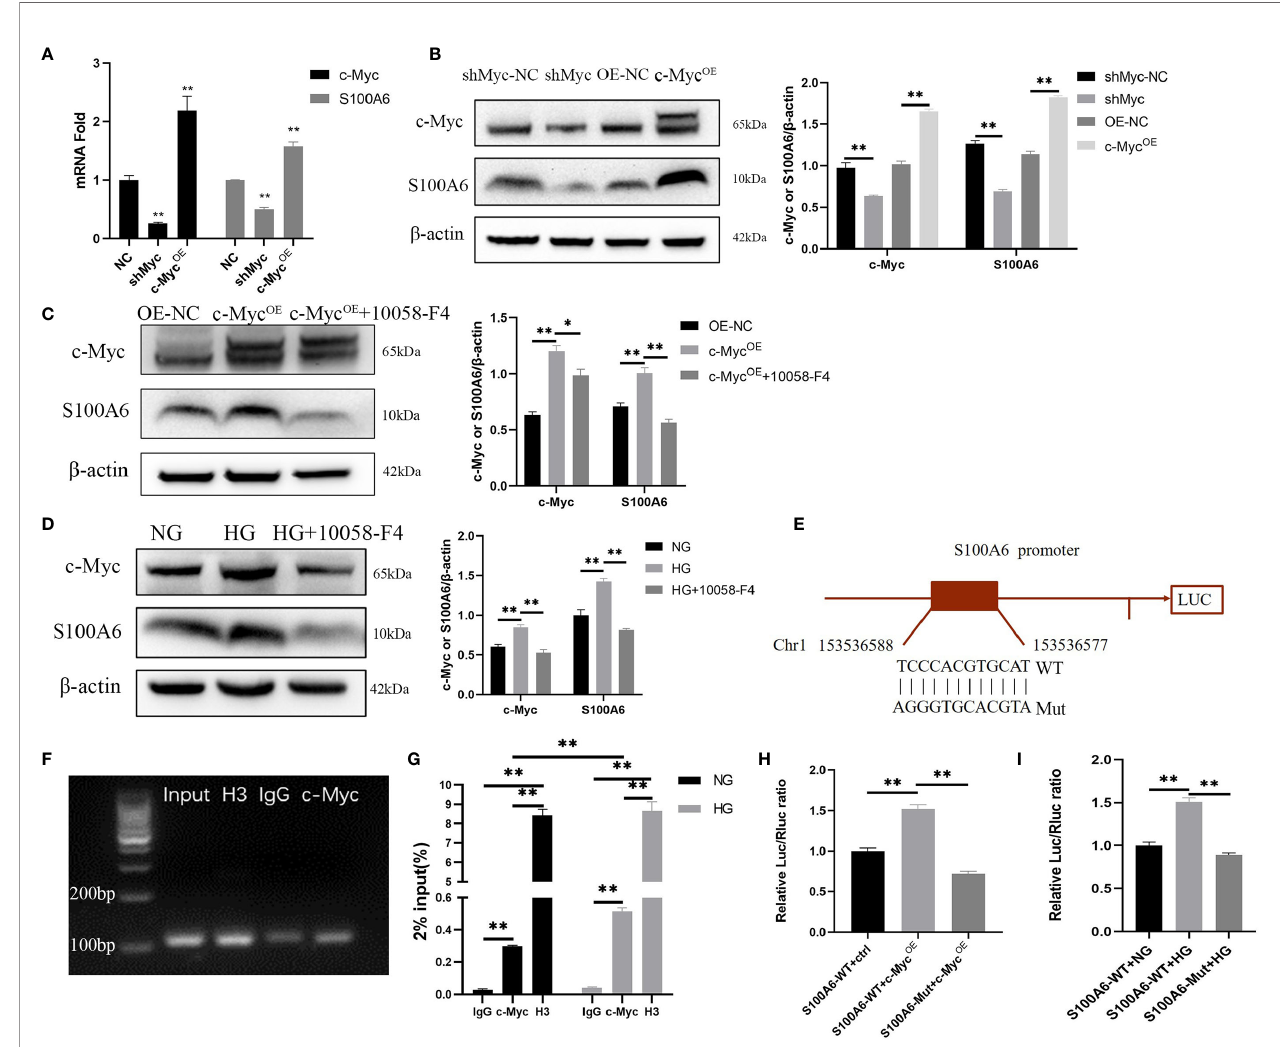
FIGURE 5 | S100A6 is directly transcriptionally regulated by c-Myc (A, B) The mRNA (A) and protein (B) expressions of c-Myc and S100A6 were determined in HaCaT cells with c-Myc overexpression or knockdown. (C, D) The protein expression levels of c-Myc and S100A6 were determined in HaCaT cells pre-treated with 10058-F4 (20 m M). (E) The predicted binding site of c-Myc in the S100A6 promoter region on the Jaspar database (http://jaspar.genereg.net/)(relative pro fi le score threshold 90%) and scheme of mutation strategies in the S100A6 promoter. WT, wild-type; Mut, mutant. (F) ChIP-qPCR products were visualized by agarose gel electrophoresis. (G) The ef fi ciency of ChIP was calculated as percent input = 2% × 2 (CT 2%Input Sample – CT IP Sample) . (H) 500ng c-Myc overexpression plasmid or control plasmid was co-transfected with 500 ng plasmids containing S100A6 gene promoter/Fire fl y luciferase construct and 50 ng Renilla into 293T cells in the NG condition. Fire fl y and Renilla luciferase activities were measured 36 h after transfection. (I) 293T cells were cultured in the NG or HG condition for 5d and then co- transfected with plasmids containing S100A6 gene promoter/Fire fl y luciferase construct and 50 ng Renilla. Fire fl y and Renilla luciferase activities were measured 36 h after transfection. OE-NC, the negative control of c-Myc overexpression. shMyc-NC, the negative control of c-Myc knockdown. Data were shown as the mean ± SEM measured in triplicate from three independent experiments. ANOVA followed by Tukey ’ s multiple comparisons test were performed to analyze the differences. * P < 0.05, ** P < mRNA ( Figure 6E ) and protein ( Figures 6F, G ) expressions of c- Myc and S100A6 were decreased in differentiated HaCaT cells compared with those of undifferentiated HaCaT cells. HaCaT cells pre-treated with S100A6 recombinant protein showed decreased protein levels of TGM1, LOR and K1 ( Figure 6H ). The mRNA and protein levels of TGM1 , LOR and K1 in knock-down S100A6 cells were higher than those in the control group ( Figures 6I, J ). High